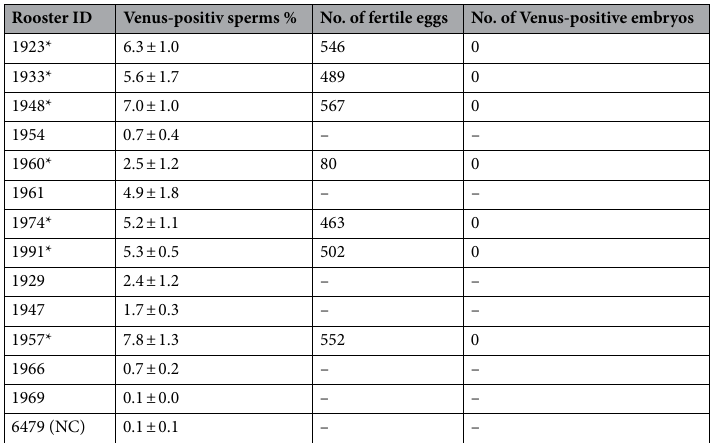
Table 3. Mean proportion of Venus-positive sperms per rooster ( x ± SD) and number of tested offspring in 14 roosters including one wildtype rooster (non-transfected) as Venus-negative control (NC). *Rooster tested for germline